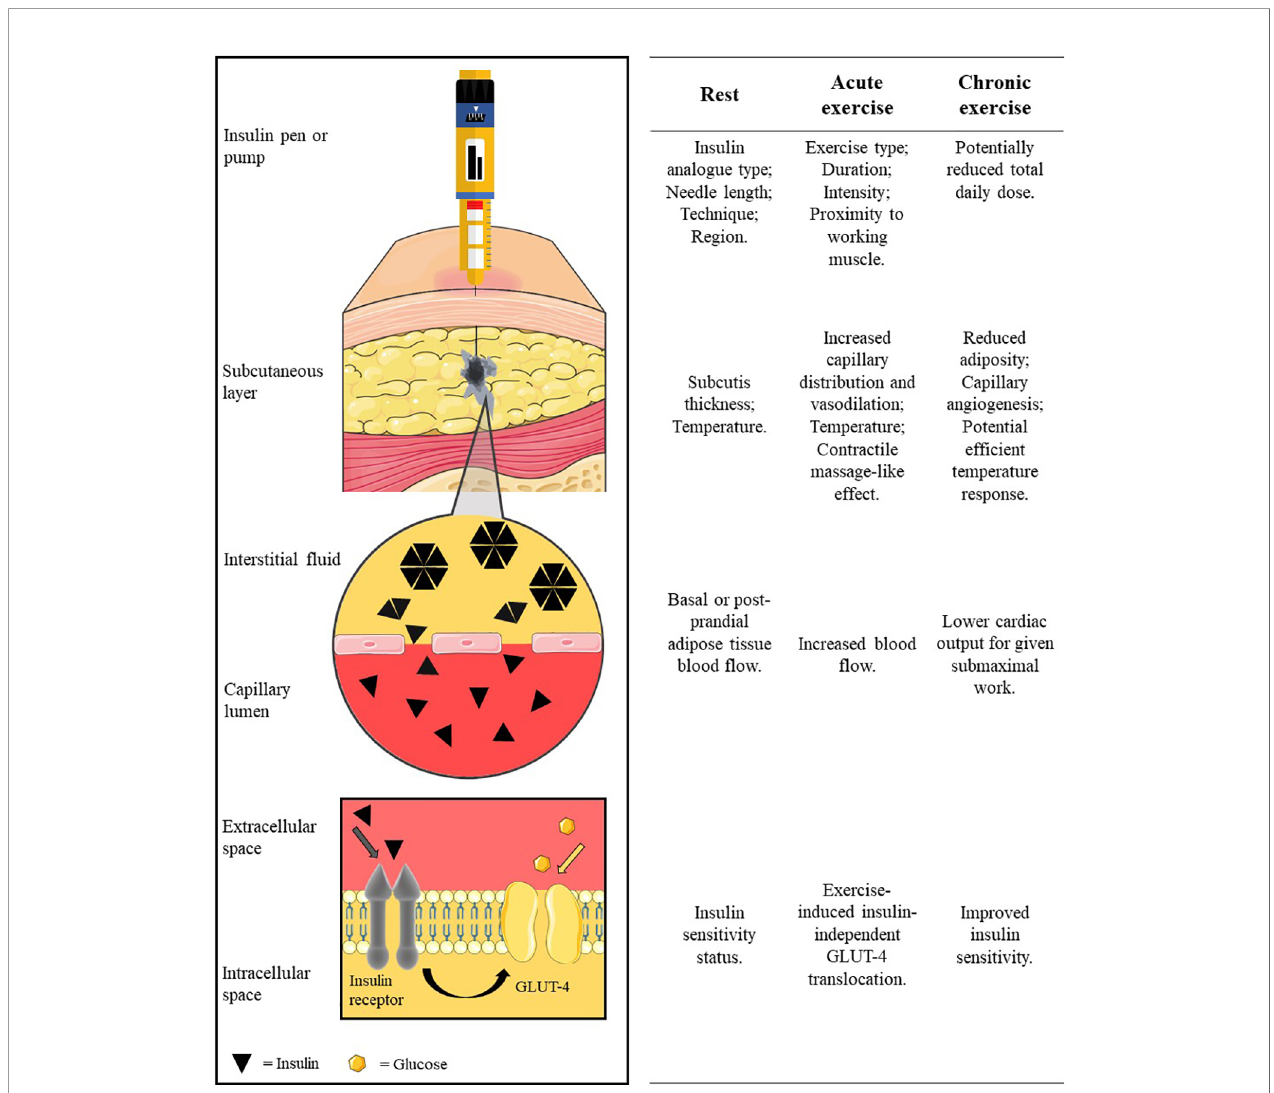
FIGURE 1 | The pathway of subcutaneously administered exogenous insulin. Insulin is injected/released from formulation in the insulin pen/pump cartridge into the subcutaneous tissue. The insulin oligomers disassociate into monomer units before translocating across the capillary endothelium into blood circulation. Insulin circulates before binding to an insulin receptor to facilitate glucose uptake into the cell (e.g. into the myocyte). Factors at rest, acute exercise, and chronic exercise which affect each stage are listed along the row beside each illustrated stage of the pathway. Insulin diffusion in the subcutaneous layer is adapted with permission from digital images of insulin depot formation 15 to 30 s after bolus injection into porcine subcutaneous tissue; authored by Jockel et al. (1). Image is not to scale for illustration purposes. Created using Servier Medical Art (https://smart.servier.com/); Sevier Medical Art by Servier is licensed under a Creative Commons